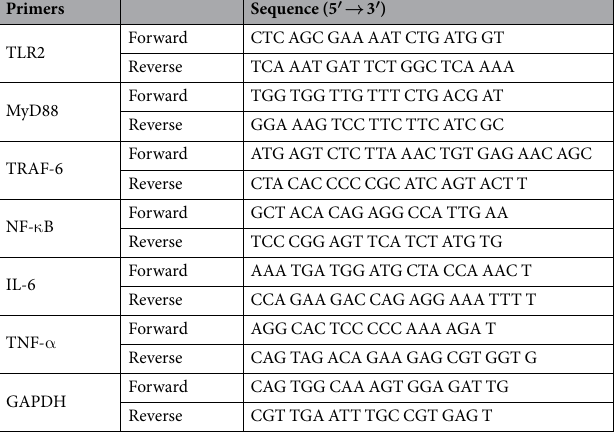
Table 1. Primers used for quantitative real-time